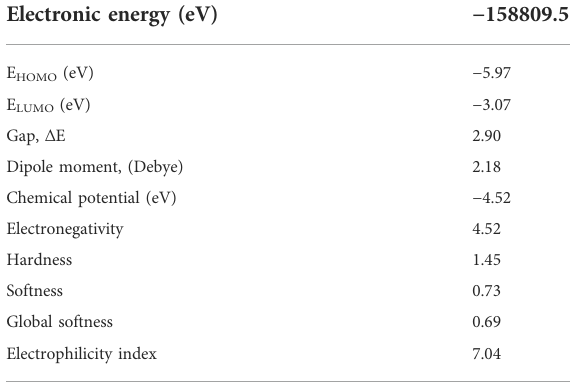
TABLE 6 Global indices of the reactivity isomaleimide